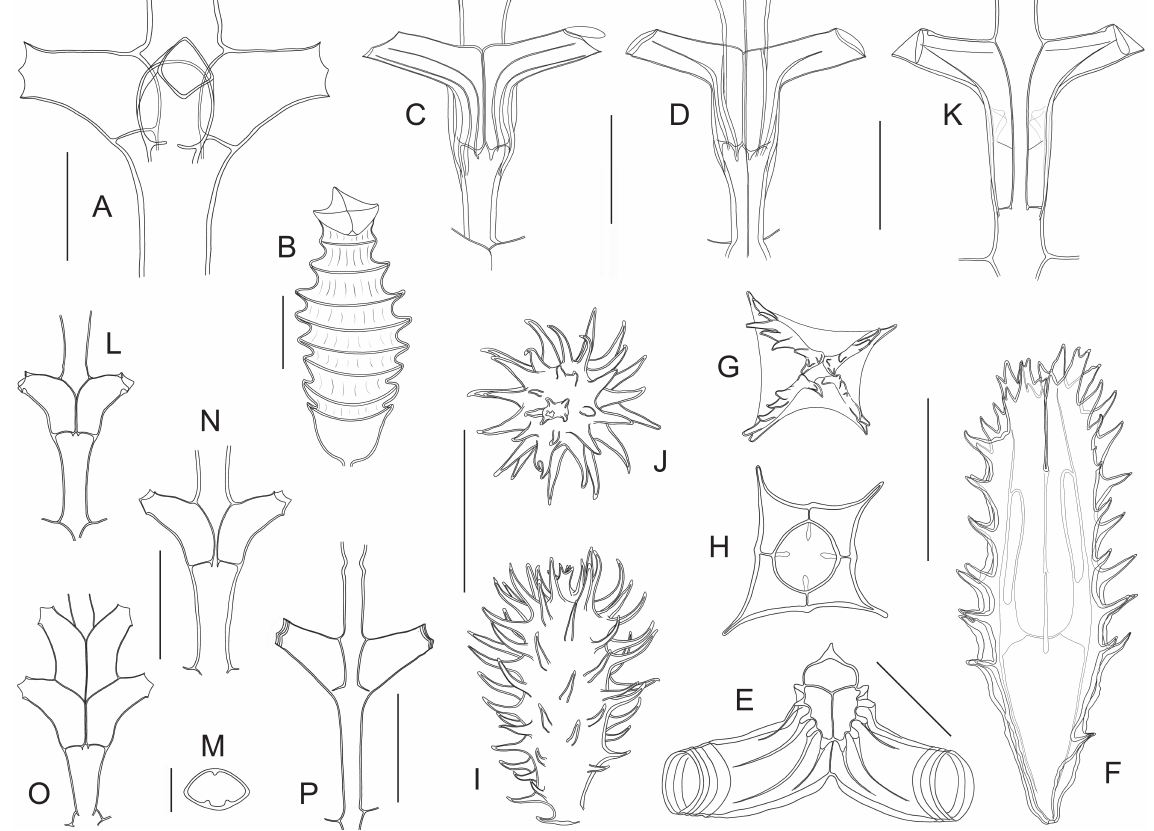
Fig. 1. ― A–B . Caminothujaria molukkana von Campenhausen, 1896 (BORDAU 2, Stn. CP1582). A . Fragment of internode with verticil of hydrothecae. B . Gonotheca. ― C–J . Diphasia cristata Billard, 1920 (BORDAU 1, Stn. CP1448). C . Pair of hydrothecae, frontal view. D . Same, dorsal view. E . Cross section through basal part of hydrothecal pair, showing perisarcal crests. F . Female gonotheca. G . Same, apical view. H . Same, cross section. I . Male gonotheca. J . Same, apical view. ― K . Diphasia